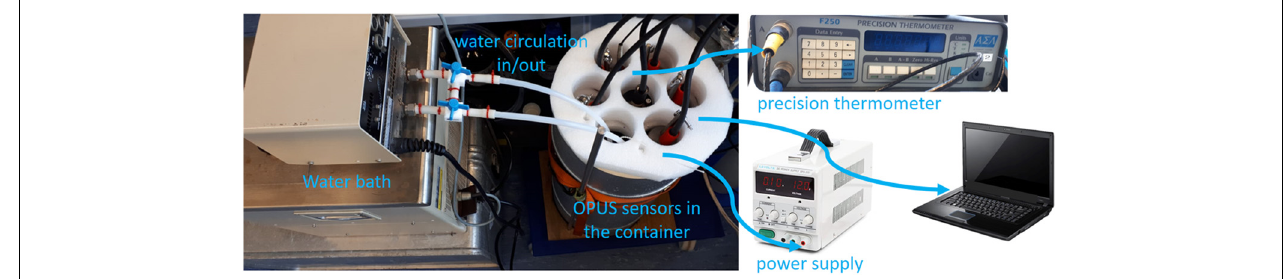
FIGURE 3 | The laboratory setup for testing of OPUS